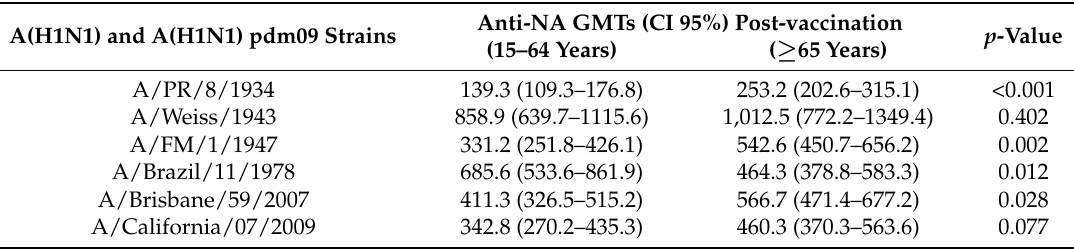
Table 3. Geometric mean titers (GMTs) of anti-NA Abs against different influenza A(H1N1) strains after seasonal flu vaccination.